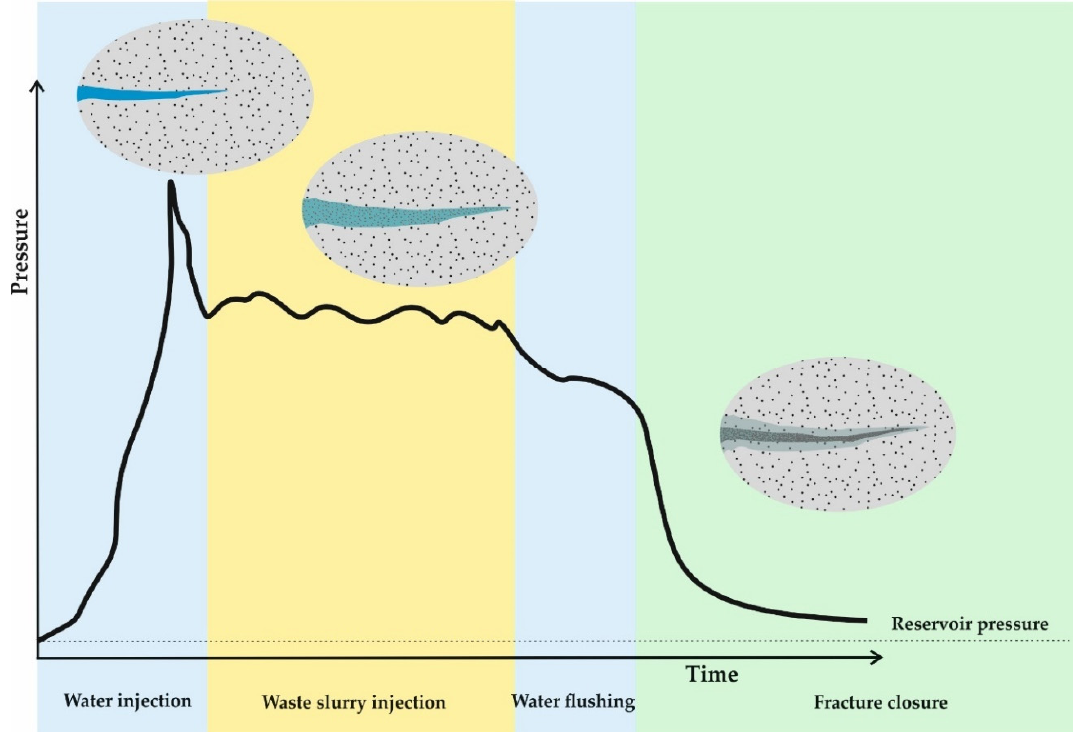
Figure 6. Pressure development during the waste slurry injection.